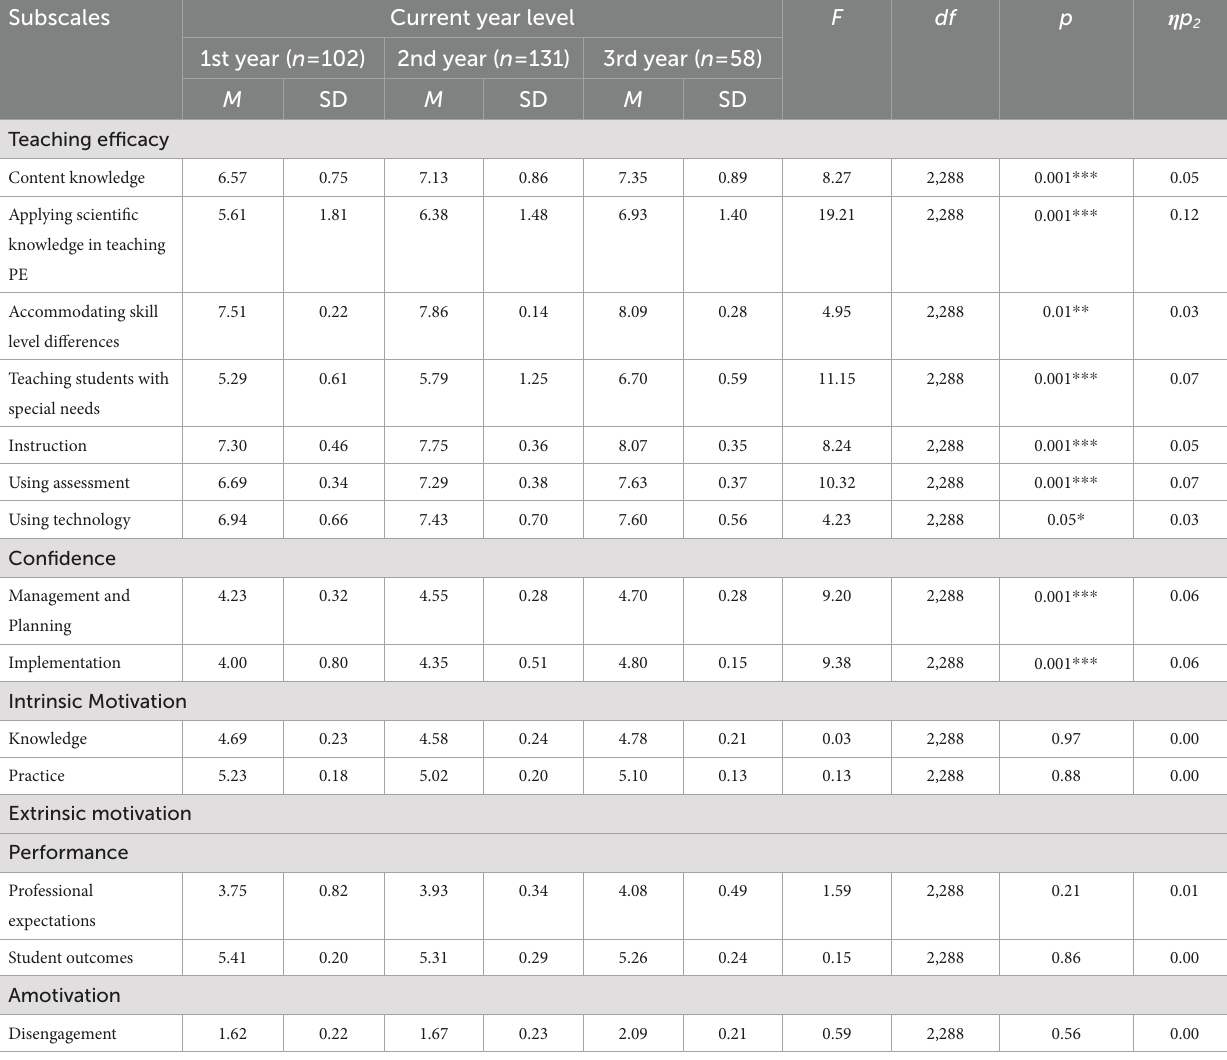
TABLE 6 Descriptive statistics and ANOVA results confidence and motivation by year